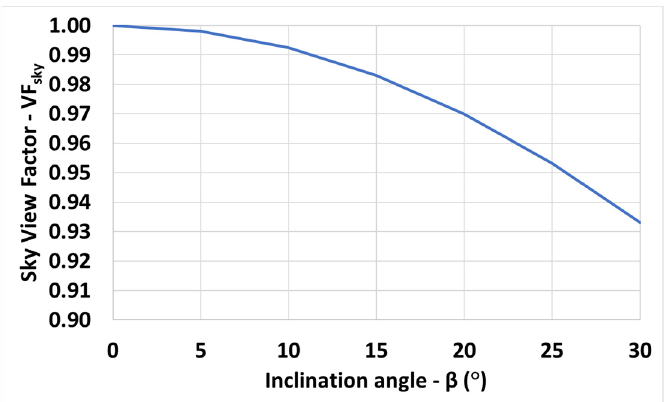
Figure 13. Variation of the sky view factor with inclination angle, 𝛽 , for a single collector on a horizontal plane.